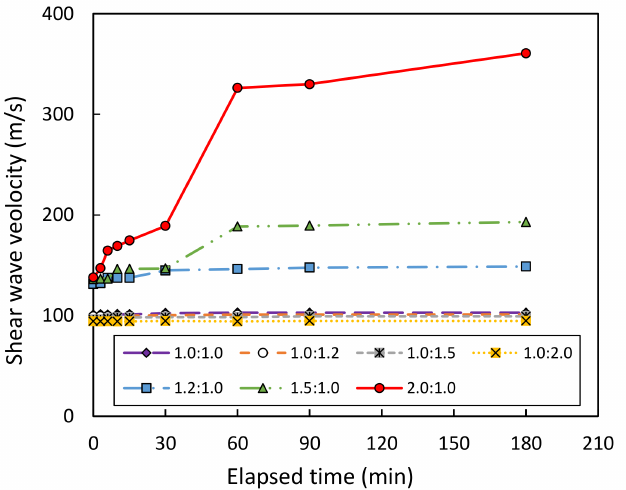
Figure 9. Shear wave velocity vs. elapsed time of bender element testing for various ratios of NaOH to Na 2 SiO 3 .